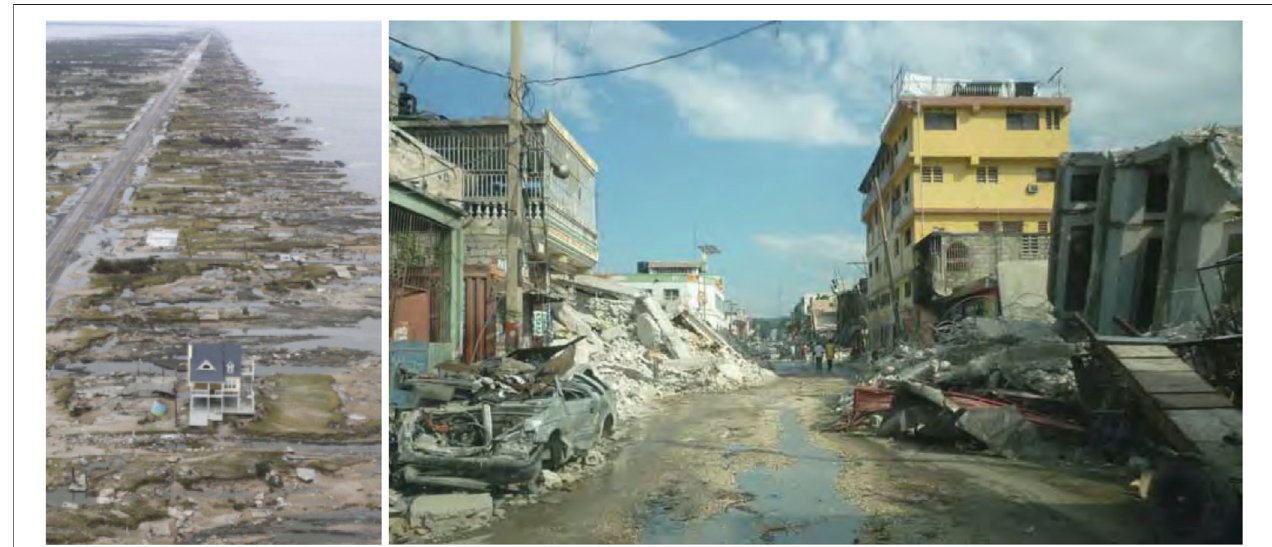
FIGURE 1 | Bolivar Island, TX, after Hurricane Ike, 2008 (left) and Port au Prince, Haiti, after 2010 earthquake (courtesy of or with permission of M. Eberhard, University of Washington, Seattle, WA, United States) (right).